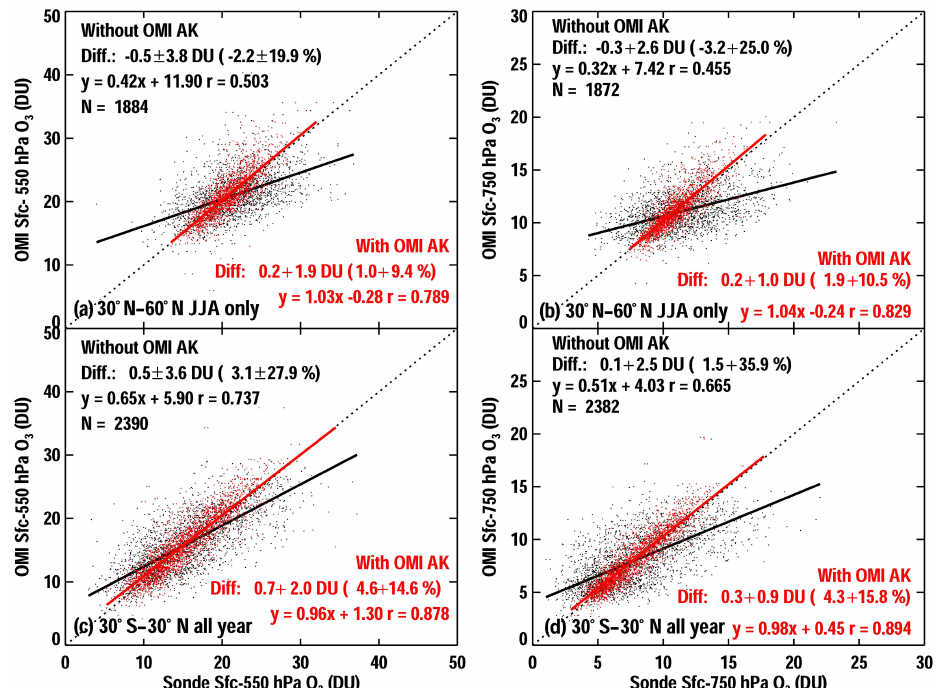
Figure 12. Similar to Fig. 9 but for comparison of lower tropospheric ozone columns during the 2004–2014 period. (a) Surface–550hPa ozone column and (b) surface–750hPa ozone column in 30–60 ◦ N during the summer; (c) and (d) same as (a) and (b) but for the